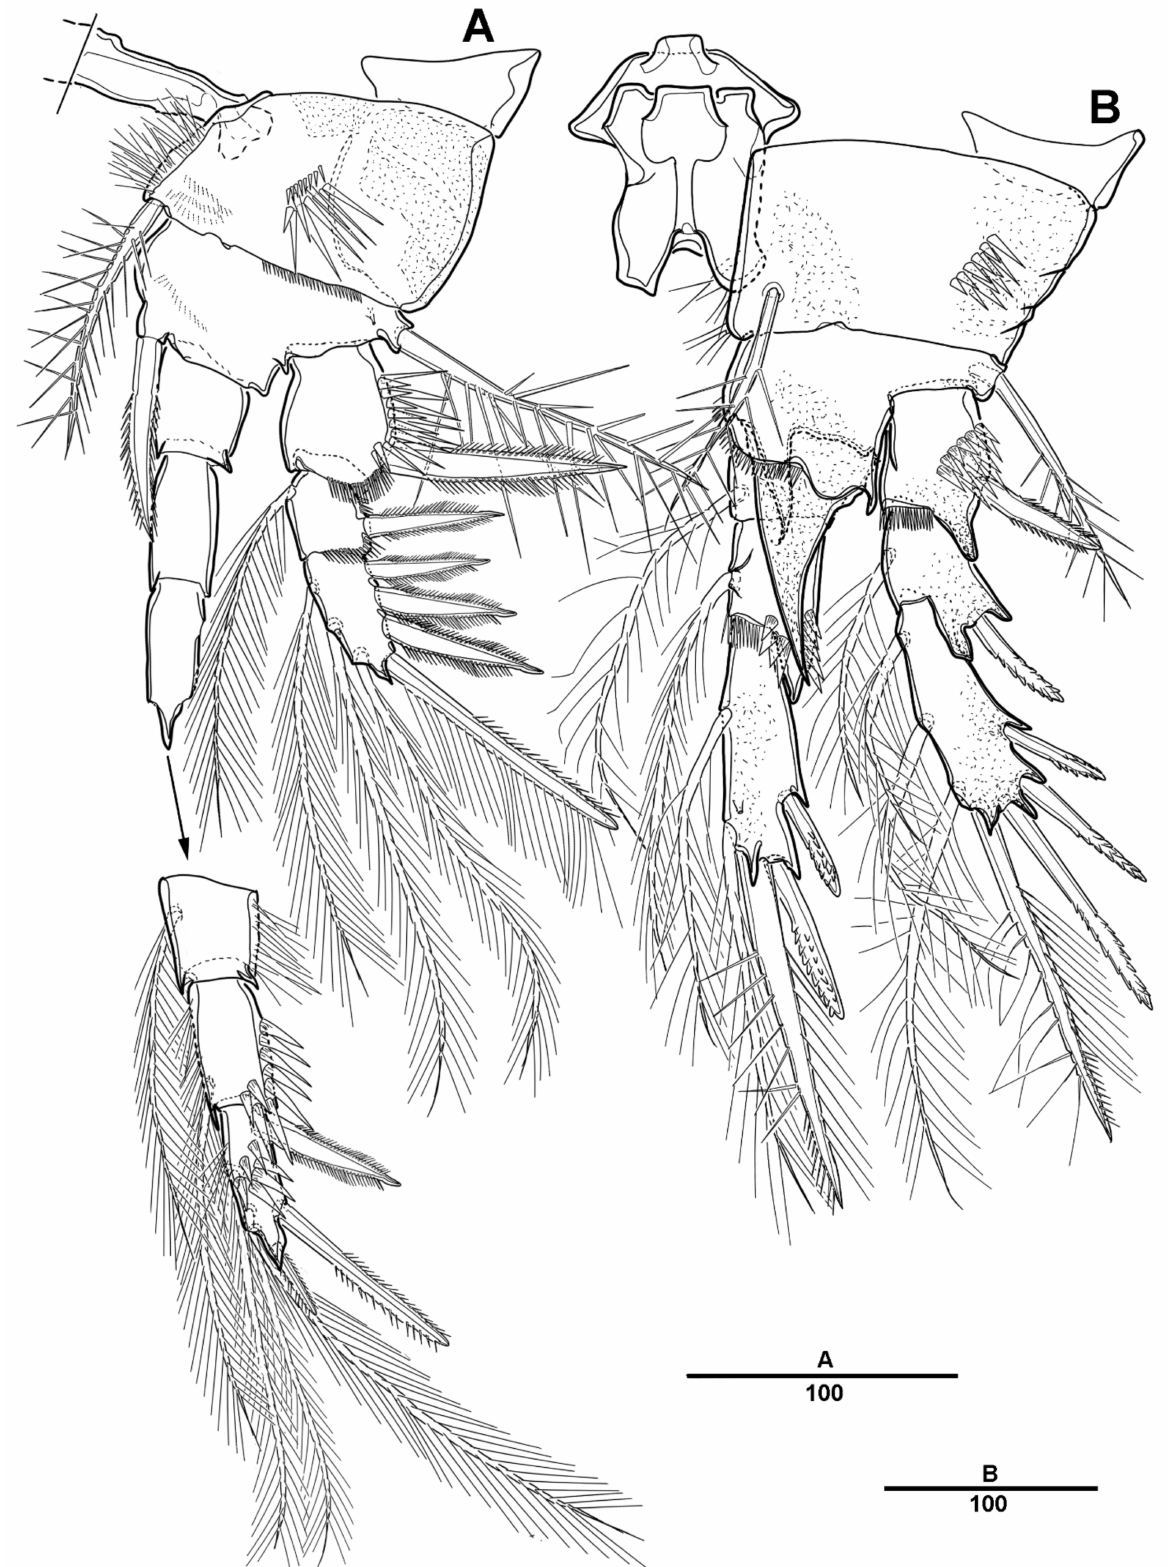
Figure 17. Scottolana wonchoeli sp. nov. holotype female: ( A ) P1, anterior; ( B ) P2, anterior. Scale bars in µ